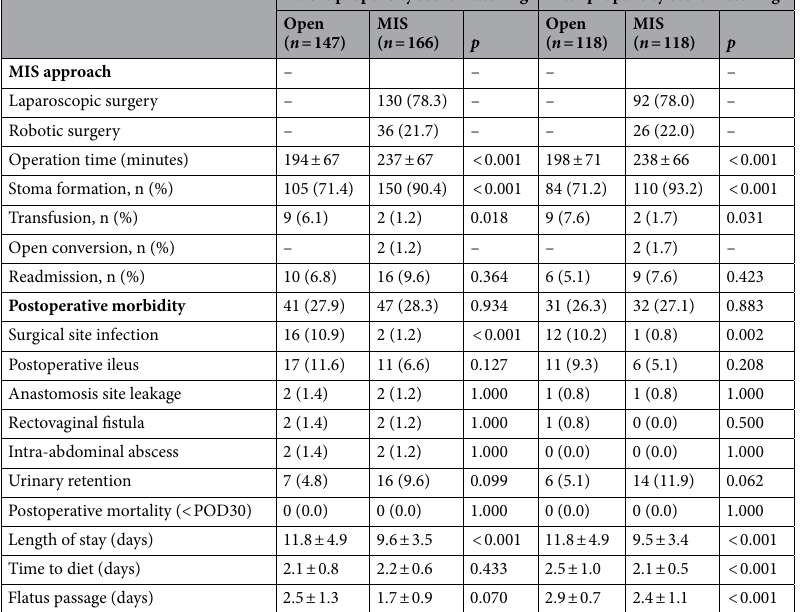
Table 5. Perioperative and short-term outcomes of patients treated with and without nCRT. nCRT neoadjuvant chemoradiotherapy, MIS minimally invasive surgery.